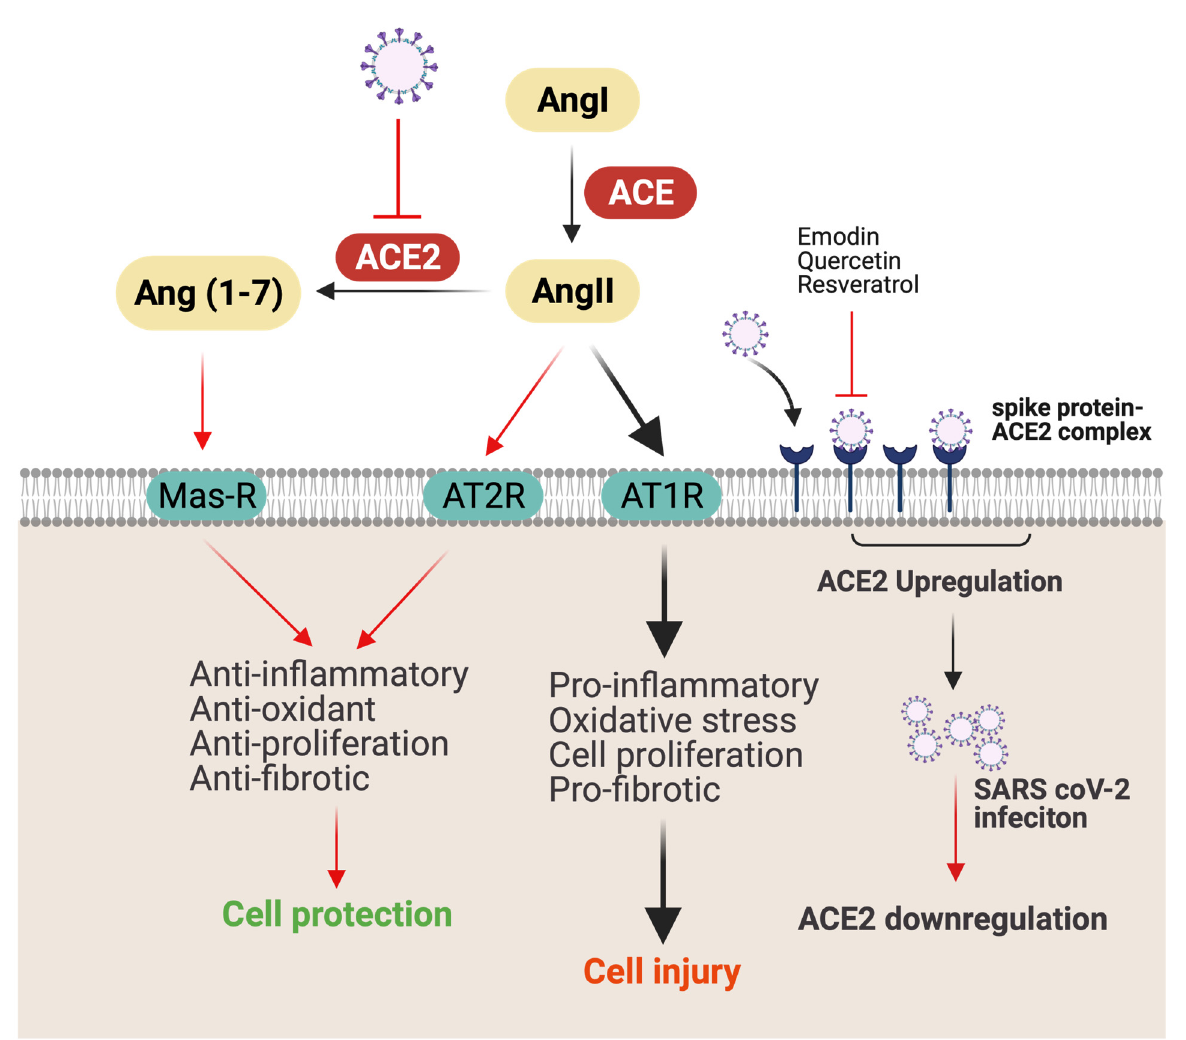
Figure 3. Possible mechanism of SARS-CoV-2 infection and lung injury. ACE converts AngI to AngII, which causes lung injury by promoting inflammation and fibrosis through AT1R. Meanwhile, by bind- ing to AT2R, AngII causes opposite effects, such as anti-inflammatory, antioxidant, antiproliferation, and antifibrotic. ACE2 coverts AngII to Ang (1–7), which ameliorates inflammation by binding to Mas receptor (Mas-R). ACEe-binding SARS-CoV-2 is internalized by endocytosis, resulting in downregulation of membrane-anchored ACE2 on the cell surface. Downregulation of ACE2 decreases AngII conversation to Ang (1–7) and increases AngII binding with AT1R, causing cellular injury. Red line indicates possible antiviral and anti-inflammatory mechanisms of bioactive compounds (figure created with Biorender.com).